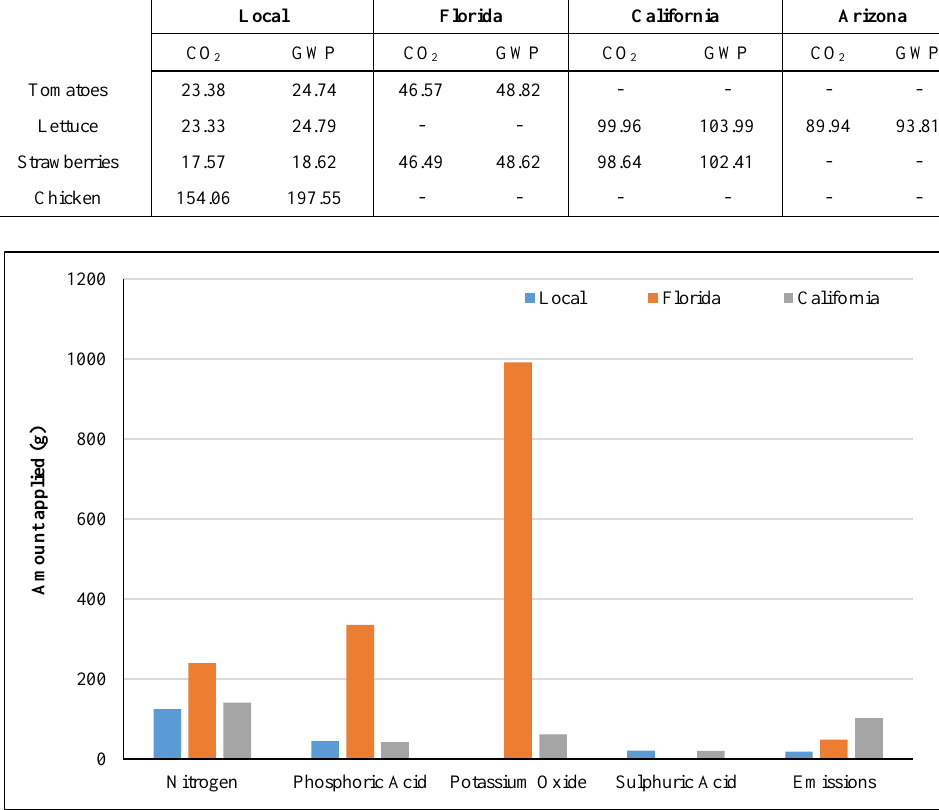
Table 2. Emissions in kg per 100 kg of product